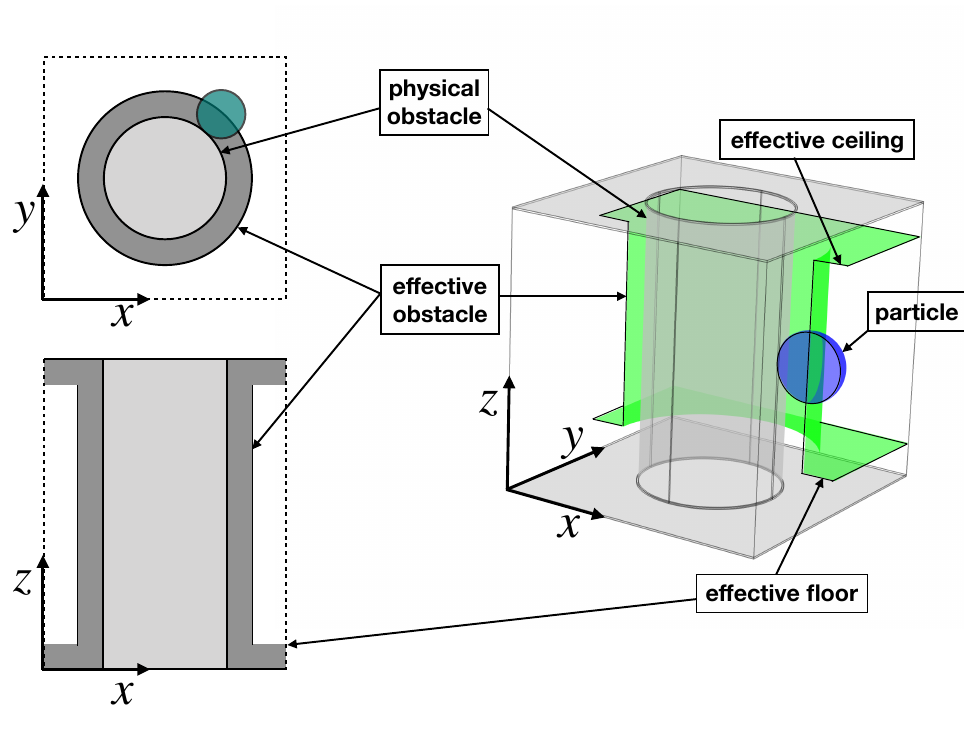
Figure 5. Effective transport domain and effective boundaries for a finite-sized particle in the excluded-volume approach. In the three-dimensional representation (right panel), only half of the effective boundaries and of the particle surface are represented for visualization